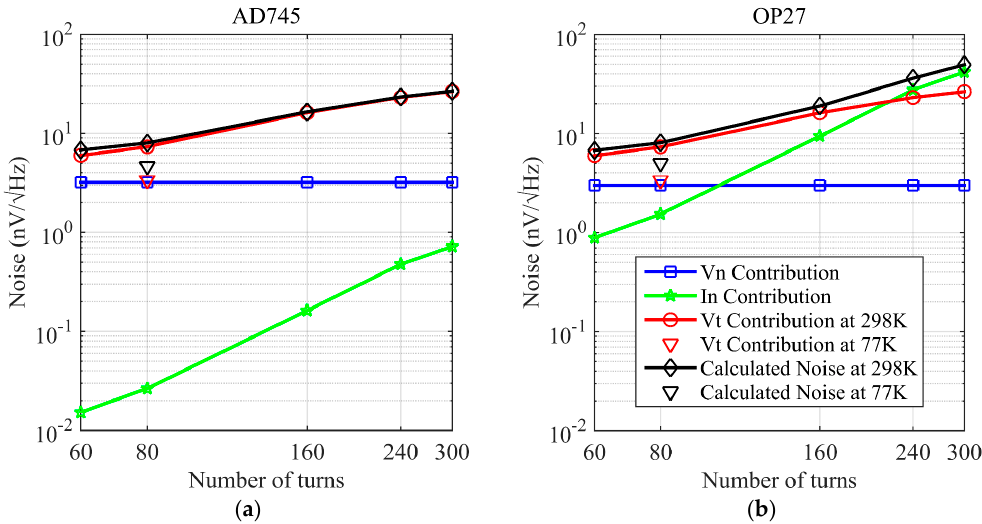
Figure 4. Noise component of the coil sensor with two preamplifiers. Blue curves are the voltage noise, green curves are the current noise, red curves are the thermal noise calculated at 298 K and black curves are the overall noise calculated at 298 K. Red downward triangle is the thermal noise calculated at 77 K, and black downward triangle is the overall noise calculated at 77 K. ( a ) AD745; ( b ) OP27.